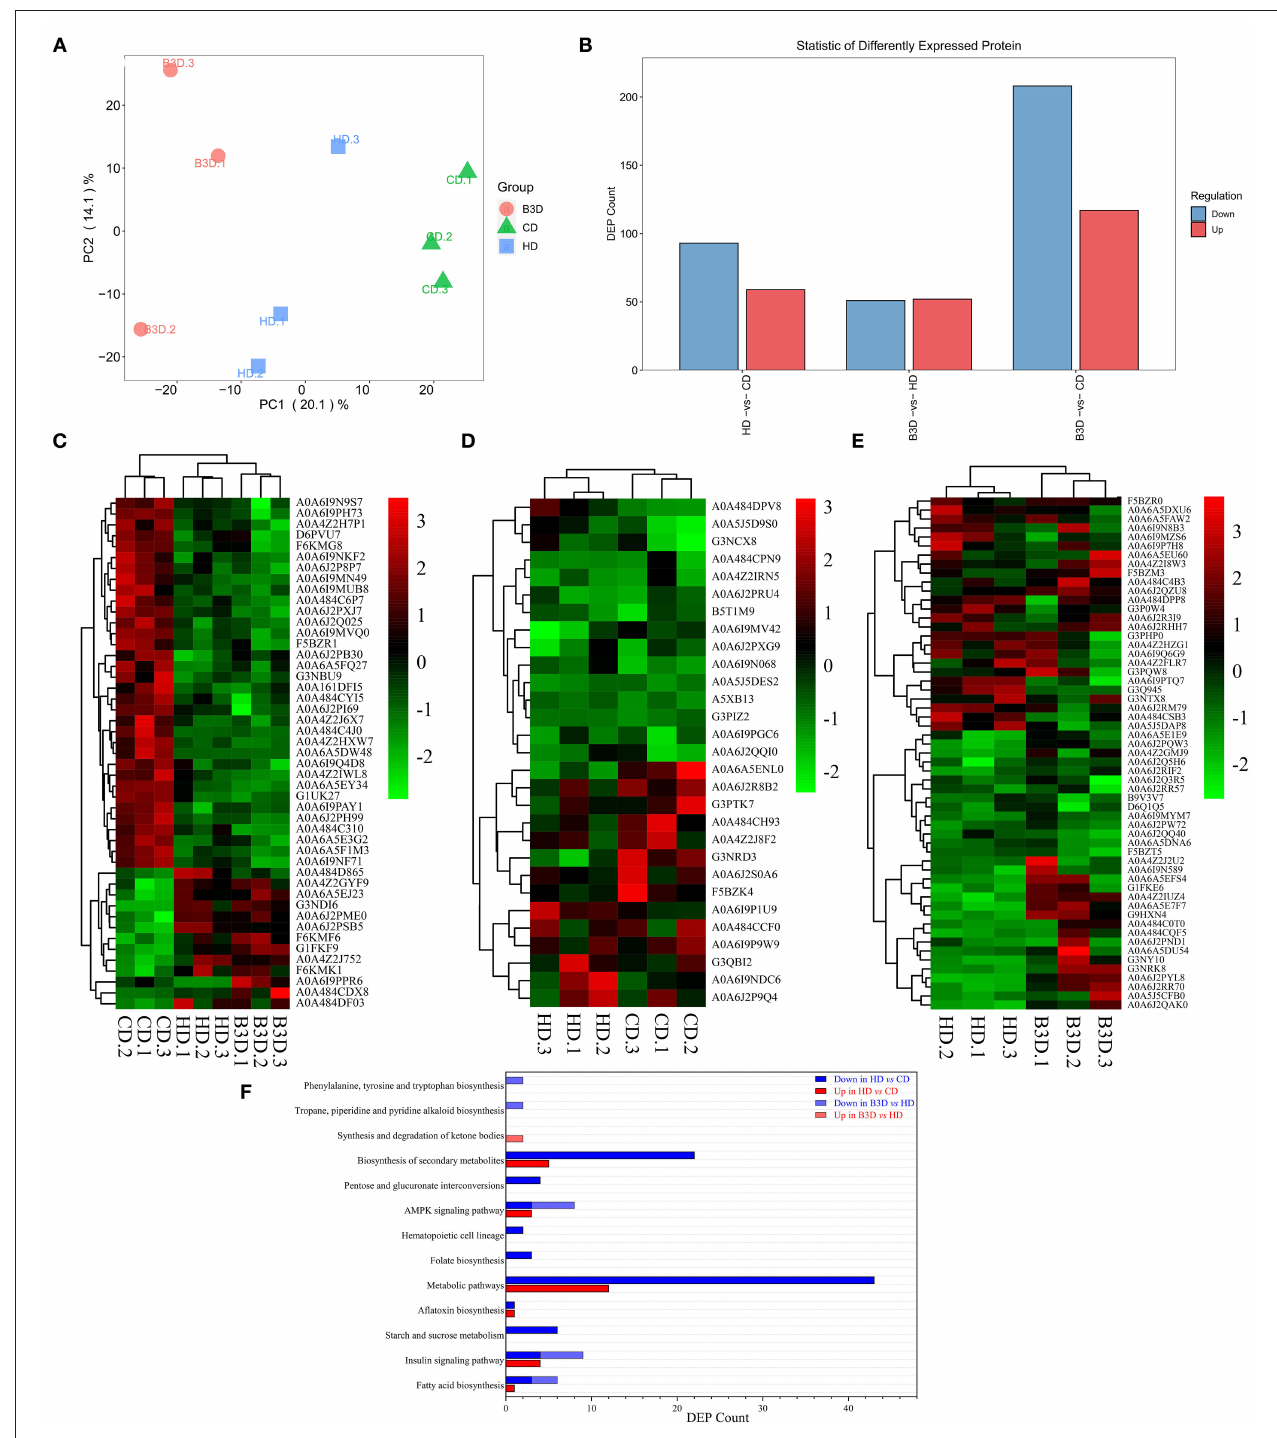
FIGURE 5 | Further analyses of proteomic profiles of liver samples in CD, HD, and B3D groups. (A) the largest two weight-scores of principal components (PC) in the protein composition: PC1 explained 20.1% of the total variability of the data, and PC2 explained 14.1% ( n = 3). (B) the amount of down or upregulated DEPs in the HD vs. CD, B3D vs. HD, and B3D vs. CD group comparisons. Proteins with a fold change larger than 1.5 and a P -value below 0.05 (using the Benjamini-Hochberg multiple testing correction test) were designated as DEPs. (C) The heatmap of DEPs in the HD group (compared to the CD group) and B3D group (compared to the HD group). (D) The heatmap of DEPs in the HD group (compared to the CD group). (E) the heatmap of DEPs in the B3D group (compared to the HD group). (F) the amount of down or upregulated DEPs in the KEGG enrichment analysis of HD vs. CD and B3D vs. HD group